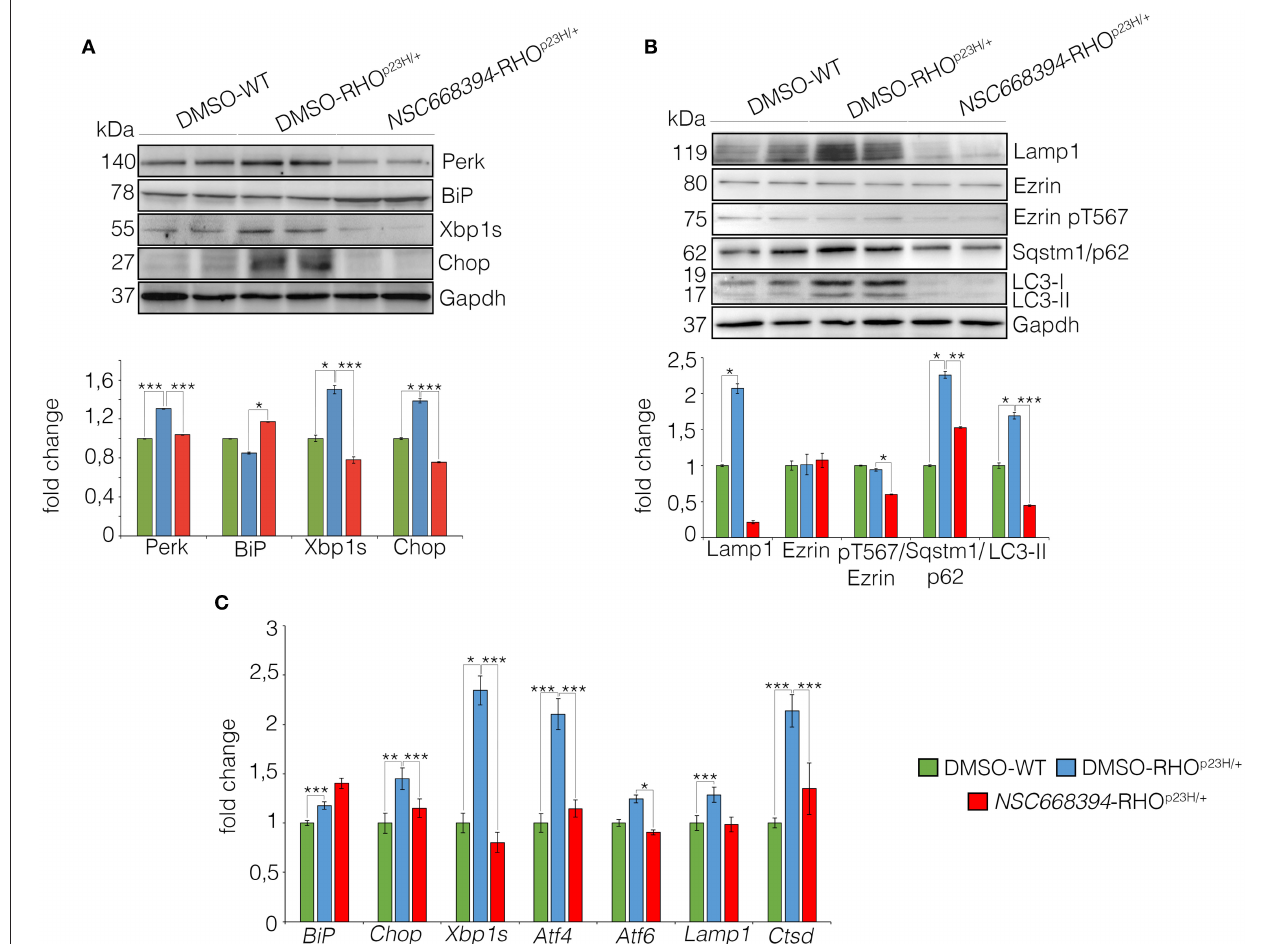
FIGURE 6 | The NSC668394 reduces ER-stress and autophagy in RHO P23H / + mice. (A) Representative Western blot analysis of Perk, BiP, Xbp1s and Chop proteins from DMSO-treated WT, DMSO-treated and NSC668394 -treated RHO P23H / + mice at PN18. The plot shows the quantification of these proteins normalized to the Gapdh loading control. Bar graphs represent mean values ± SEM of independent experiments (at least n = 3 mice). (B) Representative Western blot analysis of Lamp1, Ezrin, Ezrin pT567, Sqstm1/p62, and LC3 proteins from retina of DMSO treated WT, DMSO-treated RHO P23H / + and NSC668394 -treated RHO P23H / + mice at PN18. The plot shows the quantification of these proteins normalized to the Gapdh loading control. Bar graphs represent mean values ± SEM of independent experiments (at least n = 3 mice). (C) qRT-PCR assay for RPE of DMSO-treated WT, DMSO-treated RHO P23H / + , and NSC668394 -treated RHO P23H / + mice at PN18. The plot shows the expression level of Bip , Chop , Xbp1s , Atf4 , Atf6 , Lamp1 and Ctsd normalized to the Hprt control. Bar graphs represent means values ± SEM of independent experiments ( n = 3 mice). *** p ≤ 0.005, ** p ≤ 0.01, * p ≤ 0.05 t -test (DMSO-RHO P23H / + vs. DMSO-WT; NSC668394 -RHO P23H / + vs. DMSO-RHO P23H / + ).